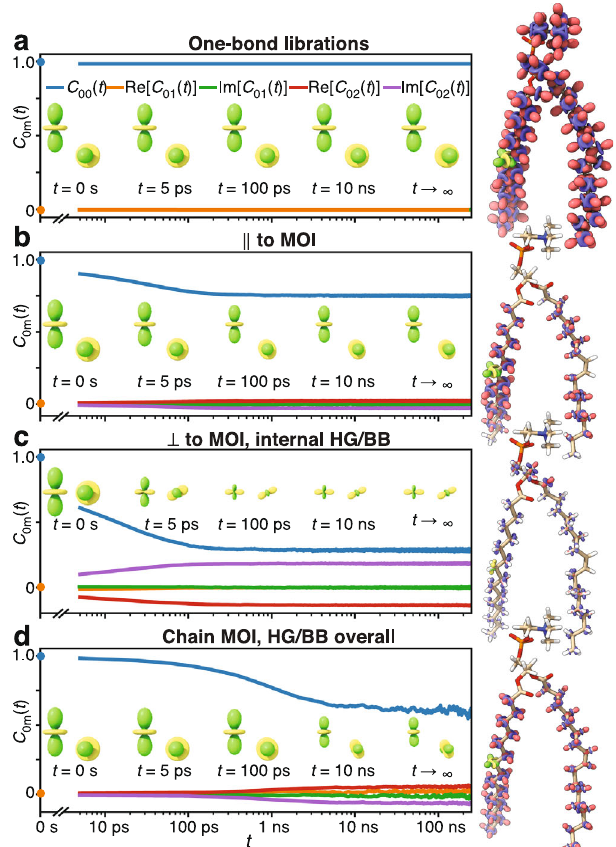
Fig. 5 Tensor reorientation due to motion. a – d The residual tensors resulting from individual motions are shown on the POPC molecule a Librational motion. b Motion parallel to the moment of inertia (no data for HG/BB and oleoyl carbons 9, 10). c Motion perpendicular to the MOI (chains), or all internal motion (one-bond librations removed) for HG/BB, and oleoyl carbons 9, 10. d Overall motions (chains de fi ned by z -axis of MOI, HG/ BB by RMS alignment of glycerol group). In a – d , pictures within the plots show the time dependence of the palmitoyl C8 tensor reorientation (green: positive; yellow: negative); the plots themselves show correlation functions de fi ning the orientation of the C8 tensor ( C 0 p ð t Þ ¼ h D 2 “ Methods ” ). In the molecule plots (right), red indicates the positive part of the tensor and blue the negative part. C8 (palmitoyl) is highlighted in the molecule plots in green and yellow. Source data are provided as a Source Data